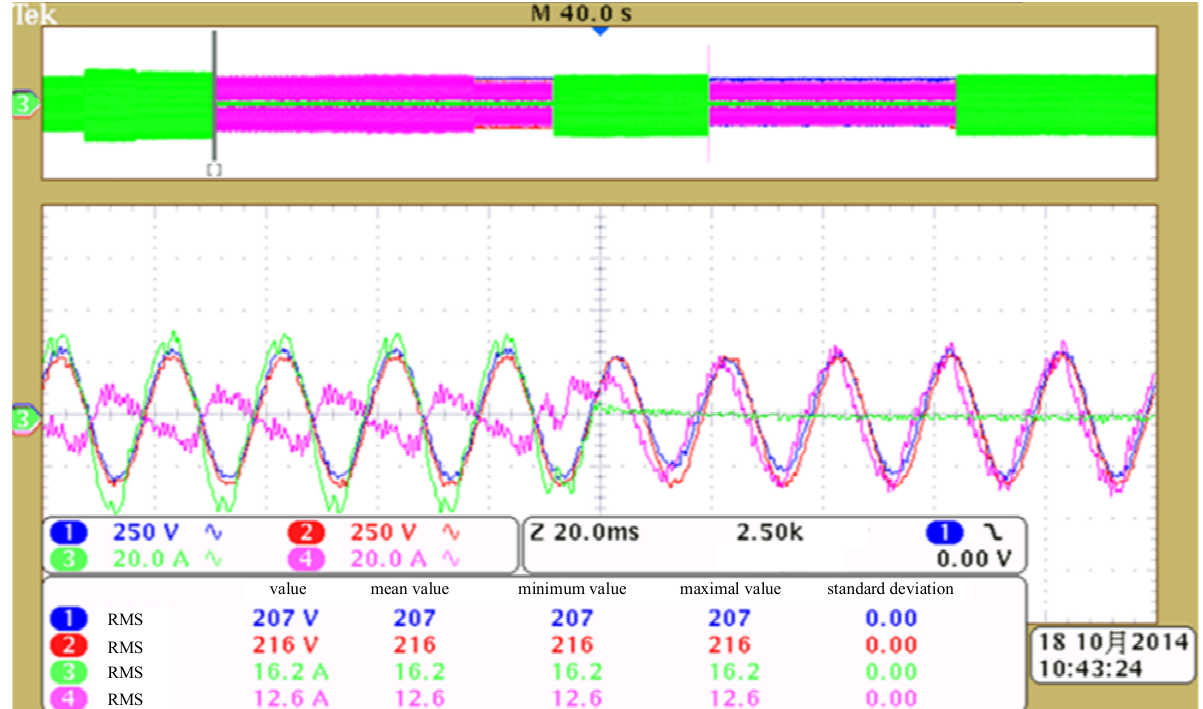
Figure 8. Conversion of the grid-connected mode to the autonomous